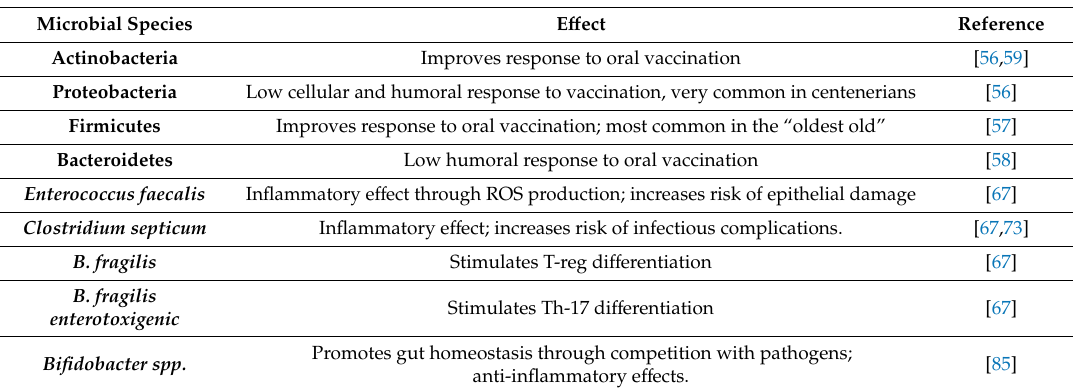
Table 1. Microbiota in the